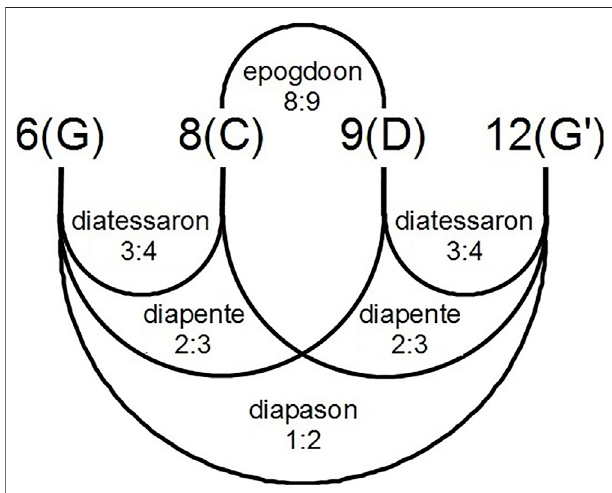
FIGURE 2 | Pythagorean music theory: diagram showing relations between epogdoon, diatessaron, diapente, and diapason, which correspond to the Major Second (9/8), Perfect Fourth (4/3), Perfect Fifth (3/2) and Octave (2/1), respectively. Pythagorean length ratios in this fi gure are the multiplicative inverse of frequency relations as used in this